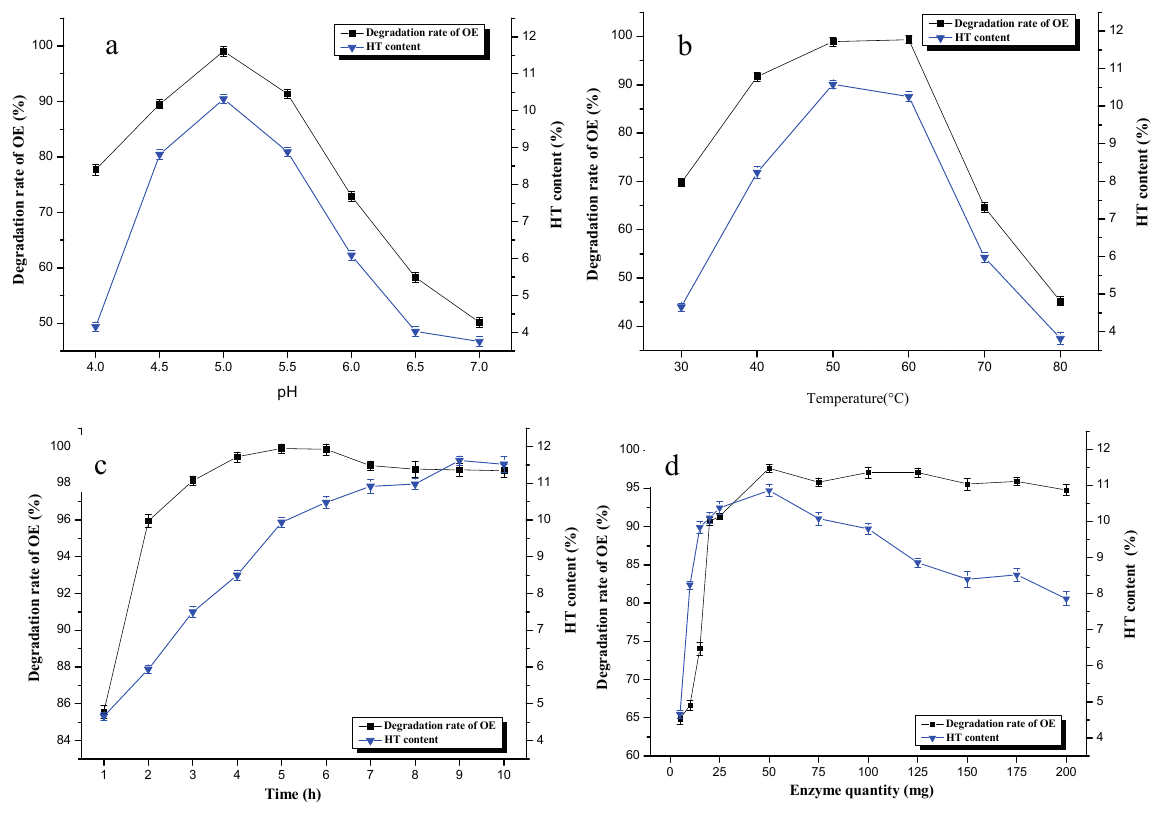
Figure 4. Effect of factor ( a ), pH; ( b ), temperature; ( c ), time; ( d ), enzyme quantity) on enzymatic hydrolysis ( n =